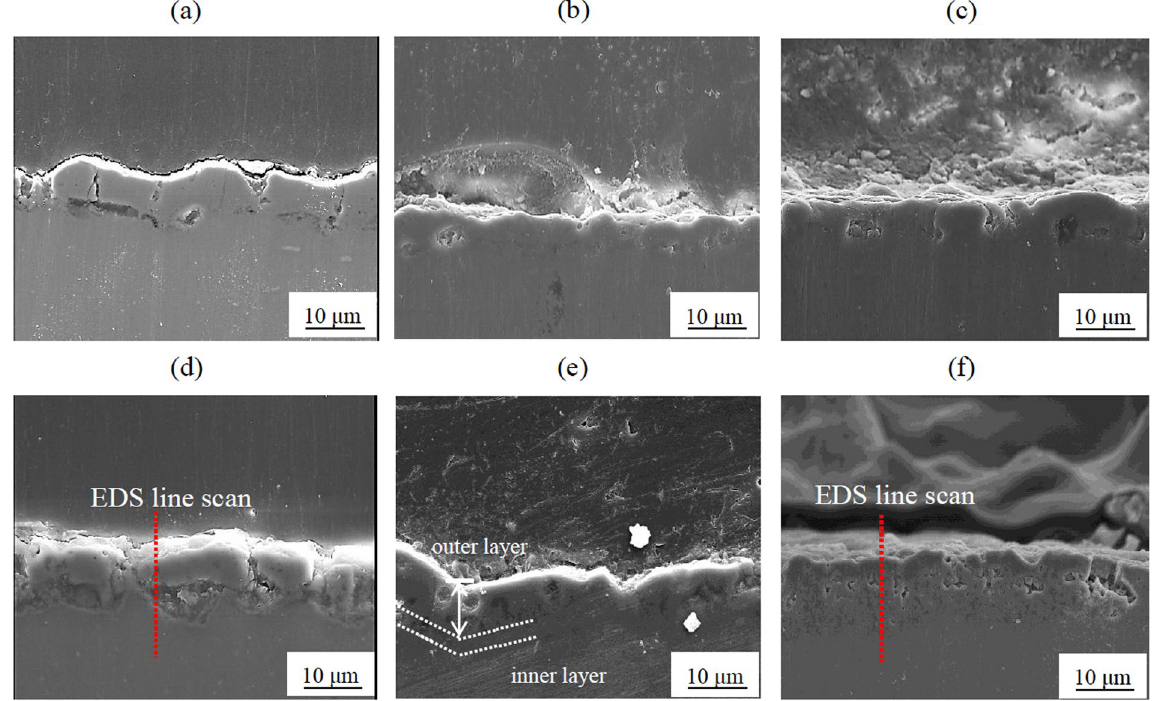
Figure 2. Cross-sectional images of the coatings formed on an Al-Mg-Si alloy by PEO at 50 mA/cm 2 ( a – c ) and 125 mA/cm 2 ( d – f ) in an electrolyte containing no Na 3 AlF 6 ( a and d ), 1.5 g/L Na 3 AlF 6 ( b and e ), and 3 g/L Na 3 AlF 6 ( c and f